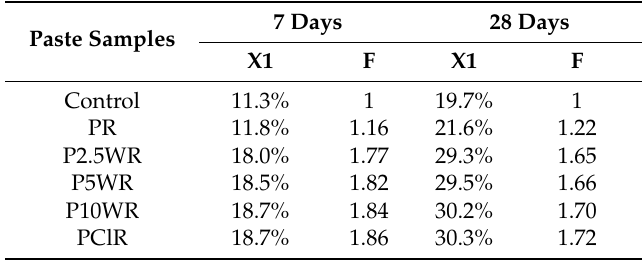
Table 3. Chemical combined water and factors of RHA